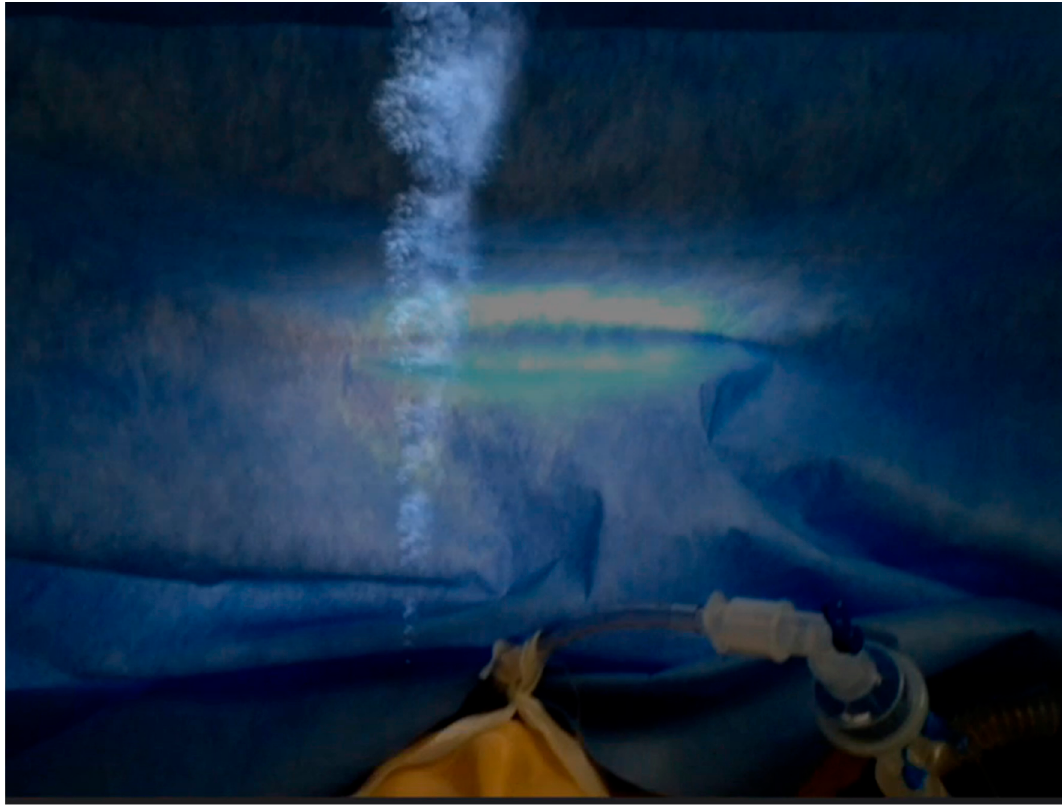
Figure 3. Student view of smoke near the patient’s airway. Source: University of Miami IT Department.